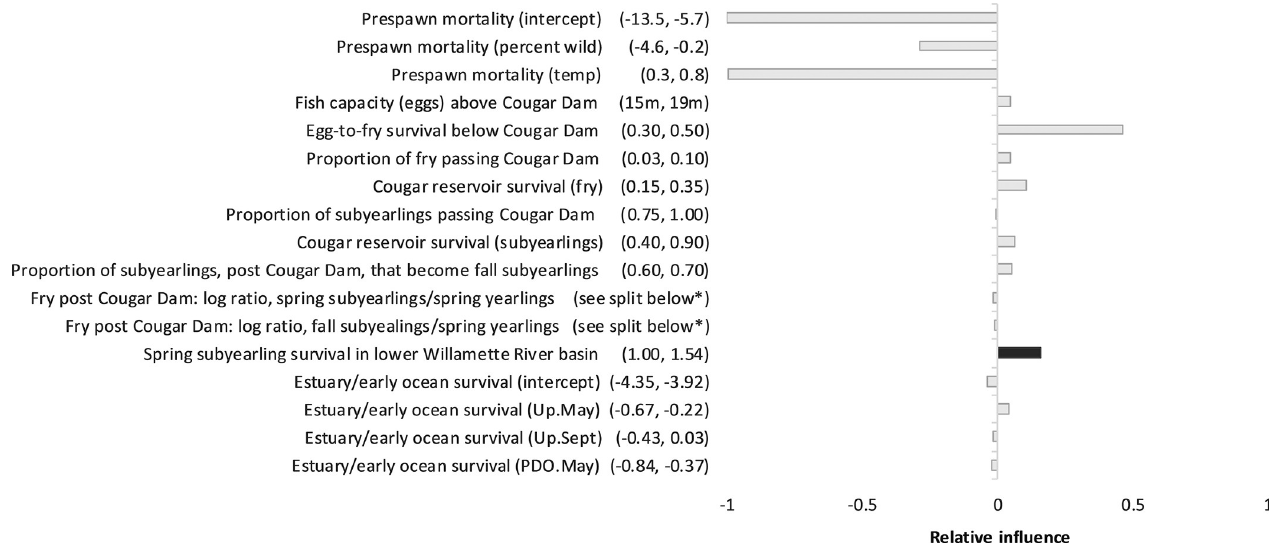
Fig 5. Sensitivity analysis on median predicted value for spawner abundance conducted on select parameters in the McKenzie Chinook salmon life cycle model. Dark bar indicates influence of increased spring subyearling survival as estimated by removal of toxic insults; parameter ranges are in parentheses. Parameter ranges for juvenile subgroups: spring subyearlings (0.10, 0.33); fall subyearlings (0.40, 0.65); and yearlings (0.10, 0.30). Abbreviations: m (million), PDO (Pacific decadal oscillation, an indicator of ocean conditions), Up.May (Coastal upwelling indices, May), and Up.Sept (Coastal upwelling indices,